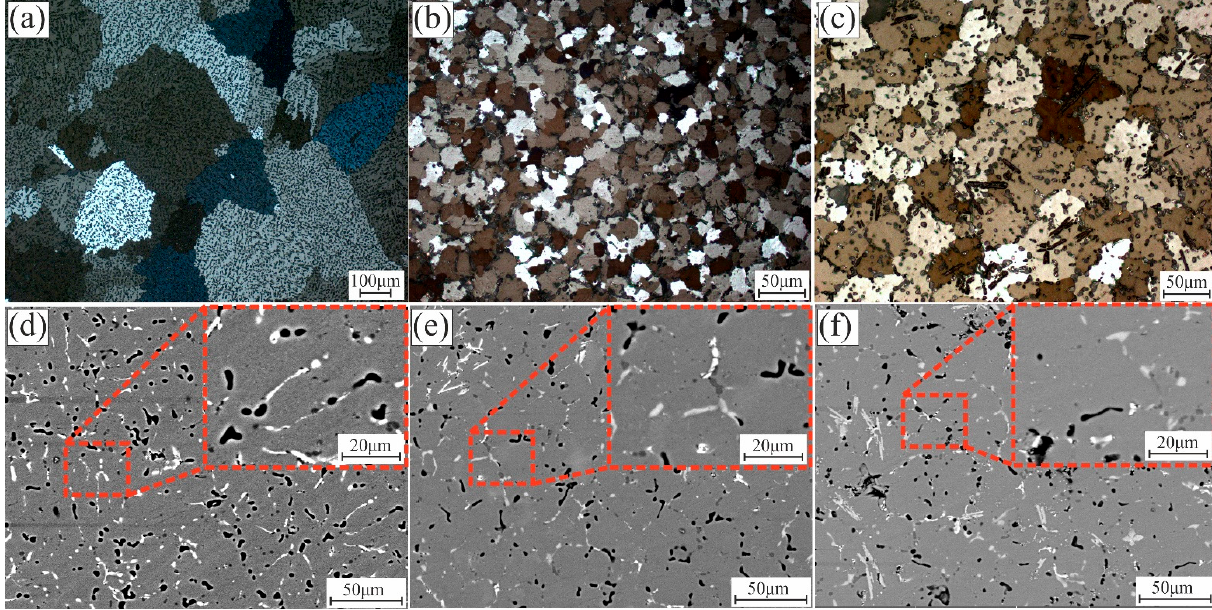
Figure 5. Microstructure of the homogenized alloys 500°C for 6.5h: ( a , d ) 7075-4%Si, ( b , e ) 7075-4%Si + ScZr, and ( c , f ) 7075-4%Si + TiB.